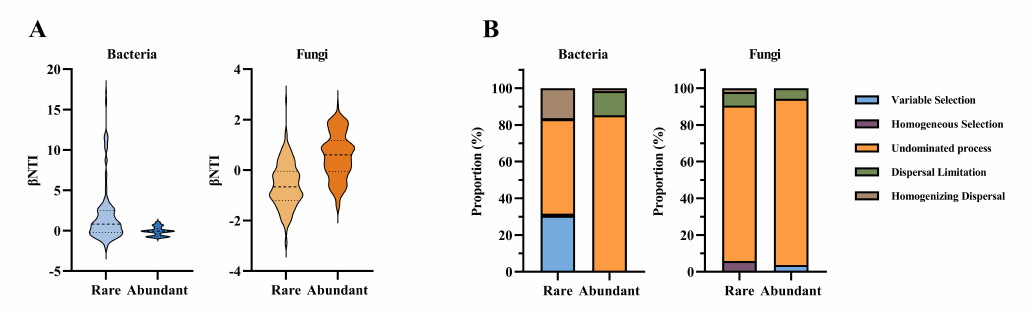
Figure 2. Assembly processes of microbial rare and abundant taxa: ( A ) Violin plot showing β NTI values of all pairwise rare and abundant bacterial and fungal communities. The lower and upper fine dotted lines represent first and third quantiles, respectively, and the thick dotted lines represent the median; and ( B ) The percentage of rare and abundant bacterial and fungal communities with different assembly processes. Table 1. Mantel test for the effects of soil properties on β NTI of rare and abundant microbial communities. Bacteria Fungi